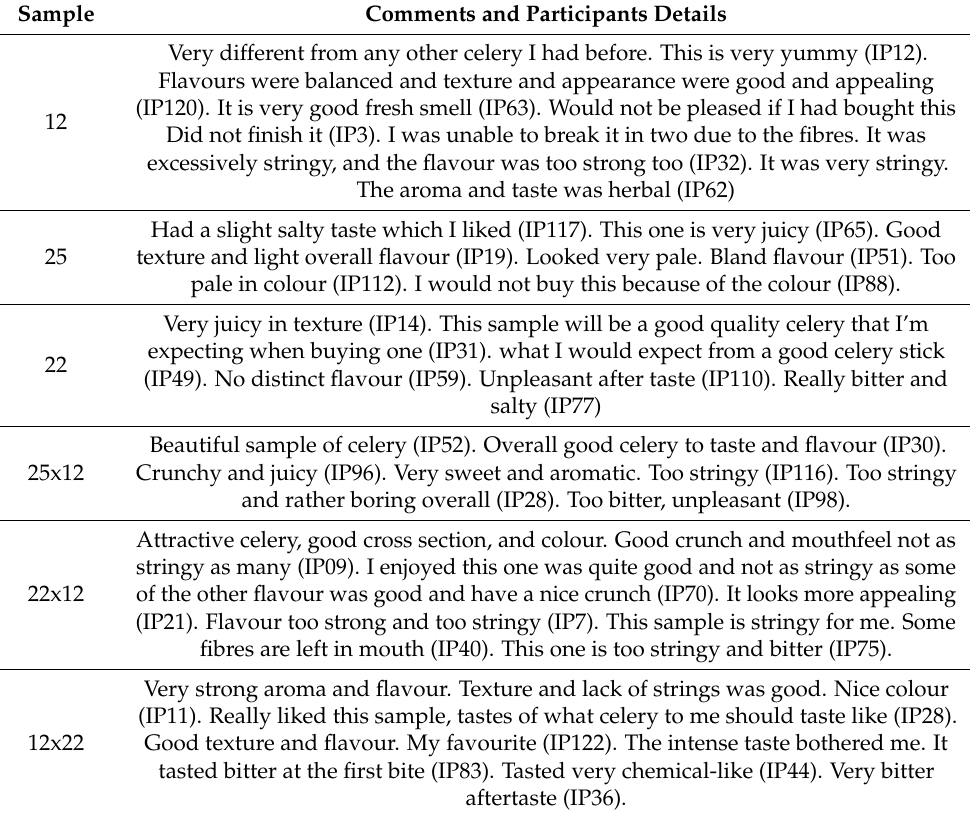
Table 8. Examples of participants’ comments (three positive and three negative comments) relating to the celery samples used in this